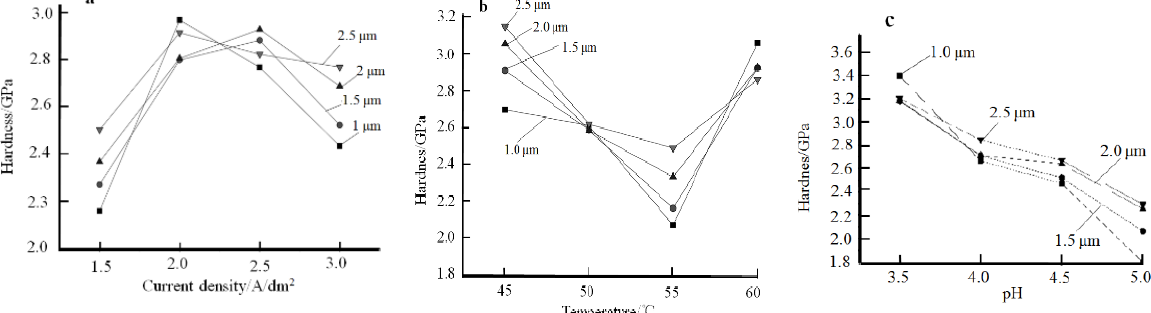
Figure 6. Effect of plating process parameters on the hardness of the layer: ( a ) Current density; ( b ) Temperature of the plating solution; ( c ) pH.